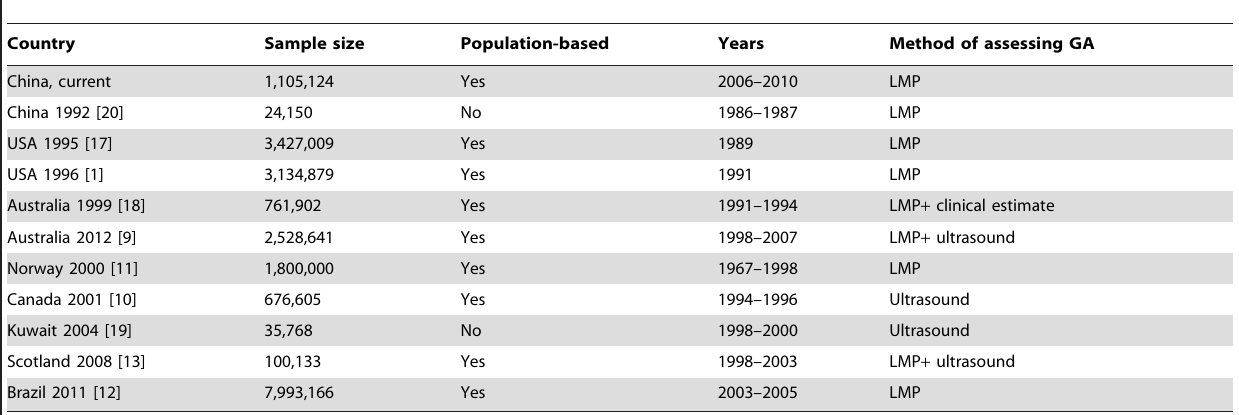
Table 4. Selected published gestational-age-specific birth weight centiles for comparison.